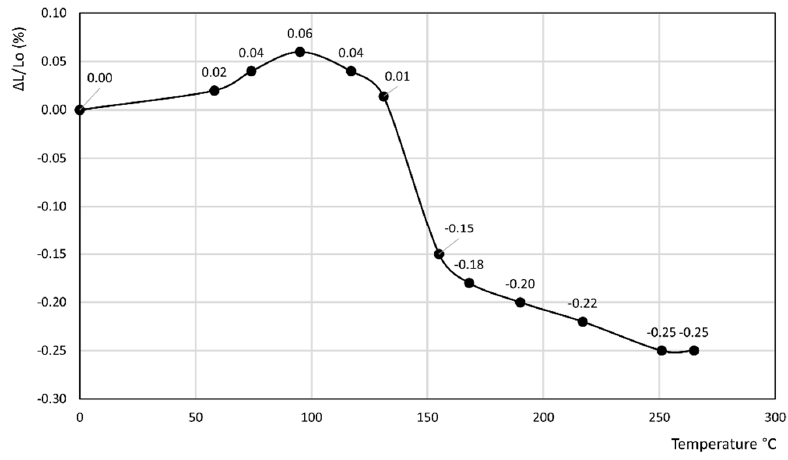
Figure 2. Thermodilatometric curve of rock 2, Ignimbrite from Sorano.